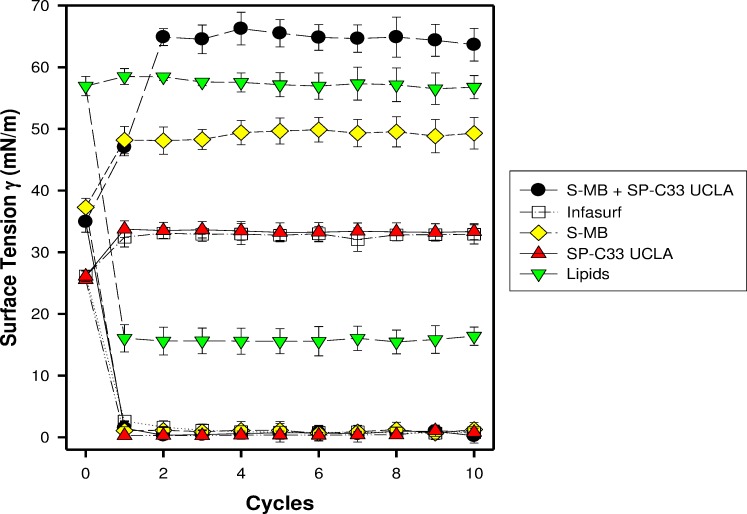
Surface activity of synthetic lung surfactants, clinical surfactant, and synthetic lipids only on the captive bubble surfactometer.Minimum and maximum surface tension values are plotted for synthetic lipids with 3% (weight ratio) Super Mini-B (S-MB), 3% SP-C33 UCLA or 1.5% S-MB + 1.5% SP-C33 UCLA, clinical surfactant (Infasurf), and synthetic lipids alone. Synthetic lipids are 5:3:2 (weight ratio) DPPC:POPC:POPG. Surface activity of S-MB surfactant, Infasurf and synthetic lipids alone have been reported previously (Walther et al., 2005; Walther et al., 2010). Data are shown as mean ± SEM of n = 4.